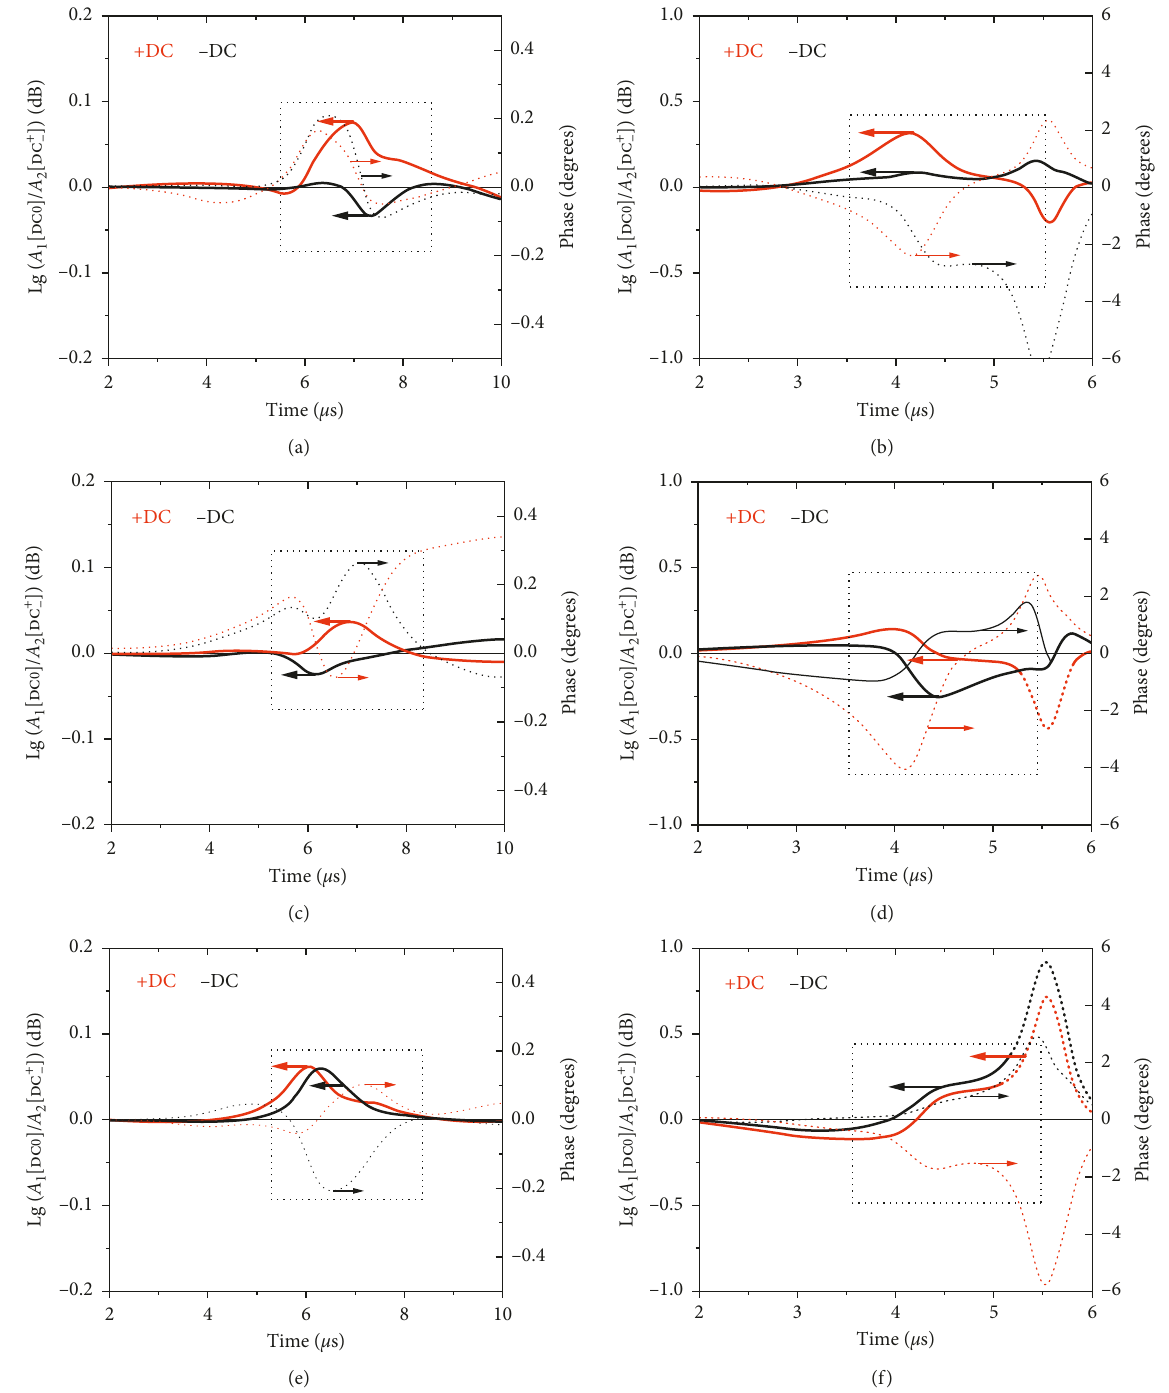
Figure 11: Experimental results of the magnitude relative (thick curves), and phase absolute (thin curves) deviations of the (a, c, and e) reflected and (b, d, and f) transmitted signals, which was measured for the positive +DC (red curve) and negative − DC (black curve) polarities. The results are compared for the induced structure (a and b) distributed on the surface of the thin plate, (c and d) the four “domains” distributed in the volume, and (e and f) the two opposite directed “domains” induced in the the top and bottom sides of ESs. The electrostatic in- structure with the two opposite directed “domains” in- teraction occurred only between two electrodes as the duced in the volume of the structural unit are shown in opposite potentials and distributed in the volume of the Figure 11(e). The periodical structure was induced when induced structure (Figure 6). In comparison with opposite electric potentials simultaneously were applied to